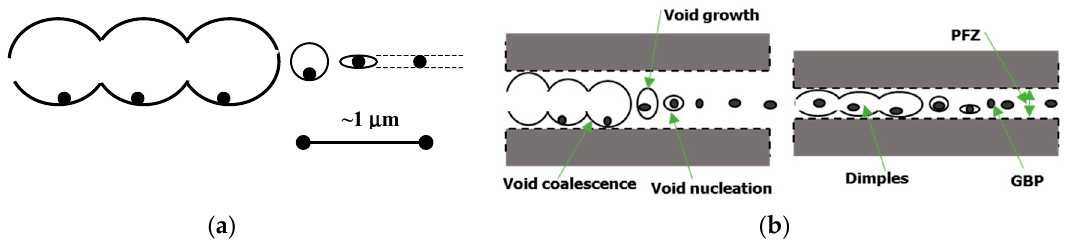
Figure 2. Schematic types of ductile intergranular fracture according [2,3]: ( a ) Ductile dimpled intergranular fracture—well-defined dimples at grain boundary usually resolved by SEM: can occur if large grain boundary precipitates as for wide soft zone adjacent to grain boundary; ( b ) Especially for precipitate harden alloys are given two diagrams illustrating dimple formation from voids at grain boundary with widely spaced grain boundary precipitate (GBP): (left) wide precipitate free zone (PFZ), (right) narrow PFZ; adapted and modified according [2].